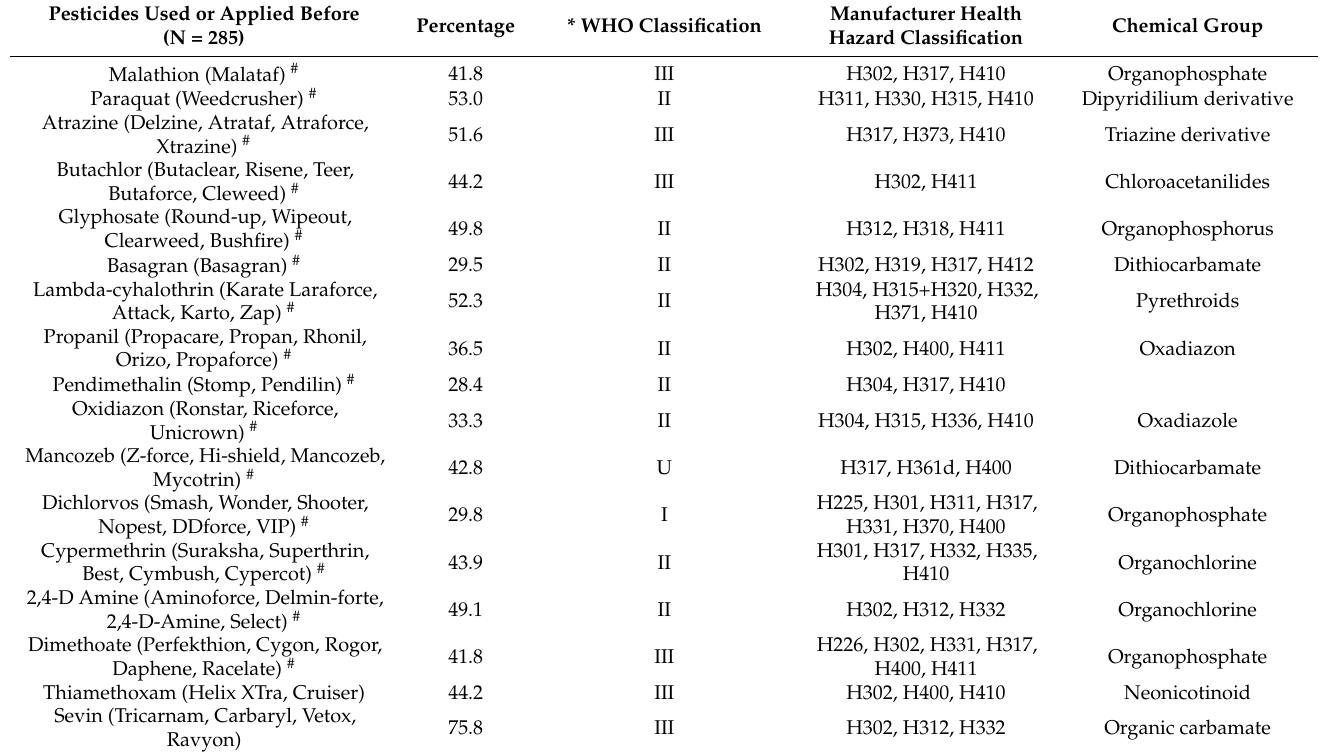
Table 3. Inventory of pesticide types used during the last two farming